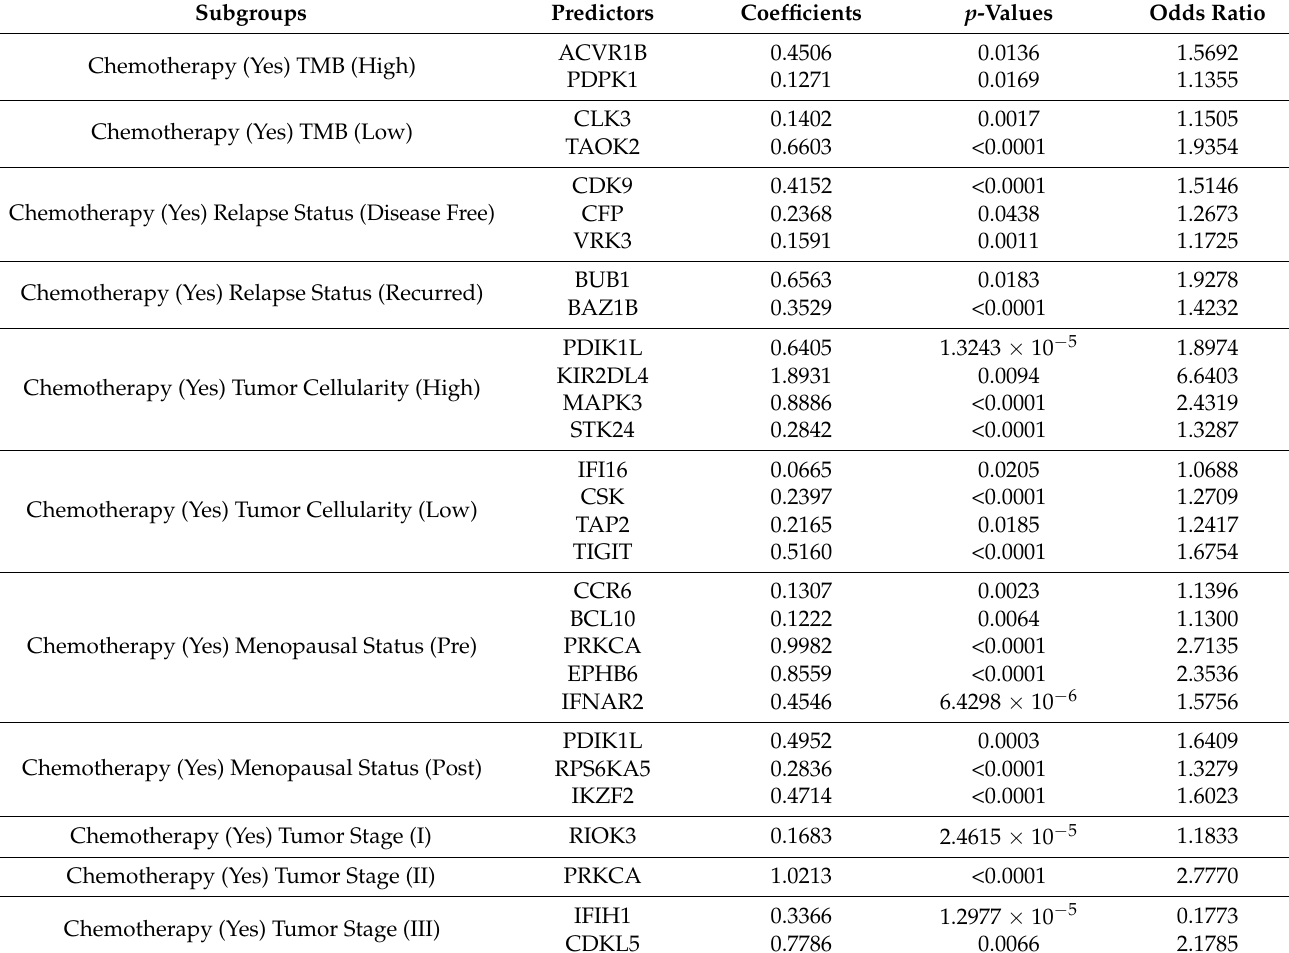
Table 1. Significant predictors that increase odds of partial remission after anti-PD-L1+chemotherapy identified by our informatics